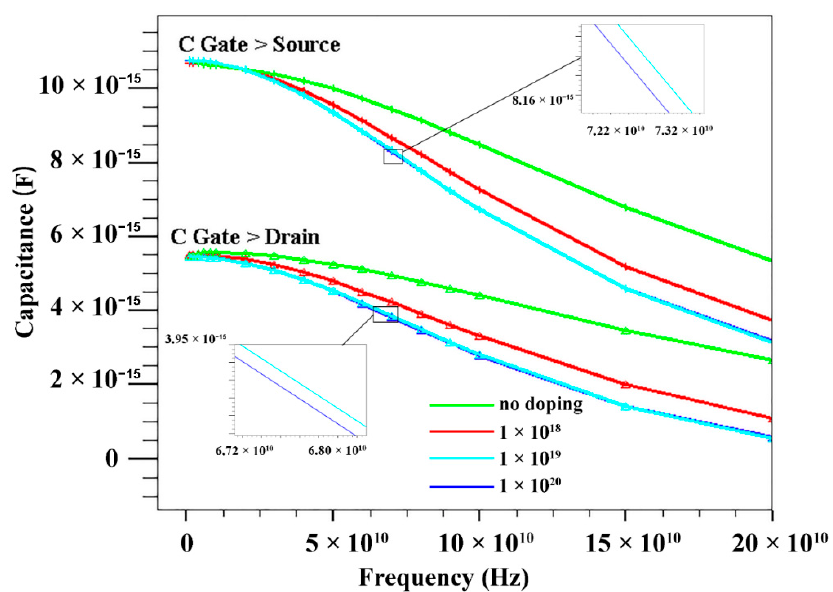
Figure 10. C gd and C gs of HEMT with different doping concentrations of AlGaN buffer layer. Table 4. Epitaxial structure and CPW loss of GaN-on-Si below 20 GHz reported in the Table 3. DC and AC simulation results of the HEMT of AlGaN buffer layer with different doping concentrations.